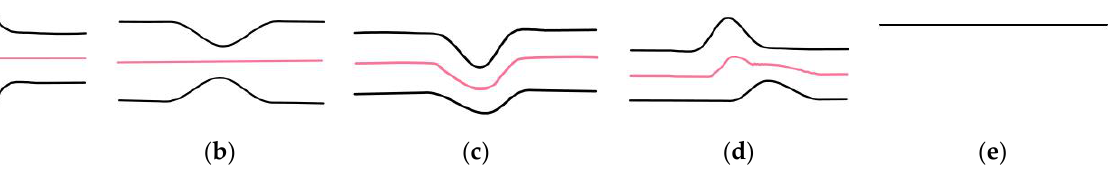
Figure 6. Several types of double lines: ( a ) convex symmetry; ( b ) concave symmetry; ( c ) curvature difference; ( d ) misplaced; ( e ) final generalized result.